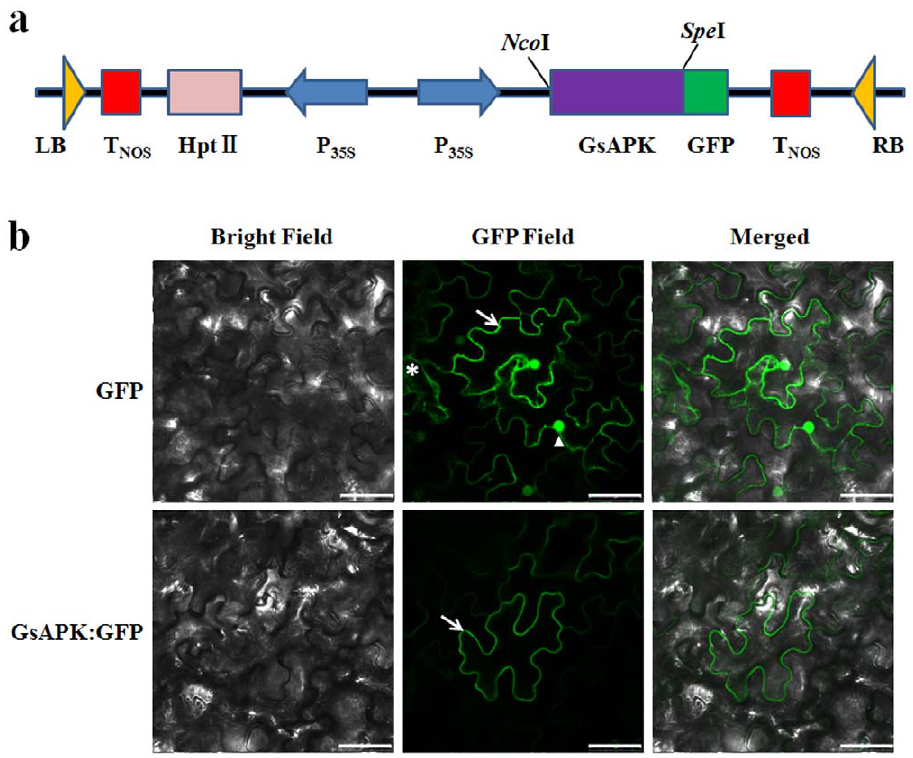
Figure 4. GsAPK protein targets to the plasma membrane of N.benthamiana plant cells. a. Schematic representation of construct used for subcellular localization of the GsAPK protein. b. Subcellular localization assay of the GsAPK:GFP fusion protein in N. benthamiana epidermal cells. Micrographs showing cells expressing GFP (control, upper lane) or GsAPK:GFP (bottom lane) fusion protein, which were examined under bright-field illumination (left), and under fluorescent-field illumination (middle) to examine GFP fluorescence, and by confocal microscopy (right) for an overlay of bright and fluorescent illumination. Scale bar, 50 m m. Arrow, plasma membrane; asterisk, cytosol; triangle, nucleus.